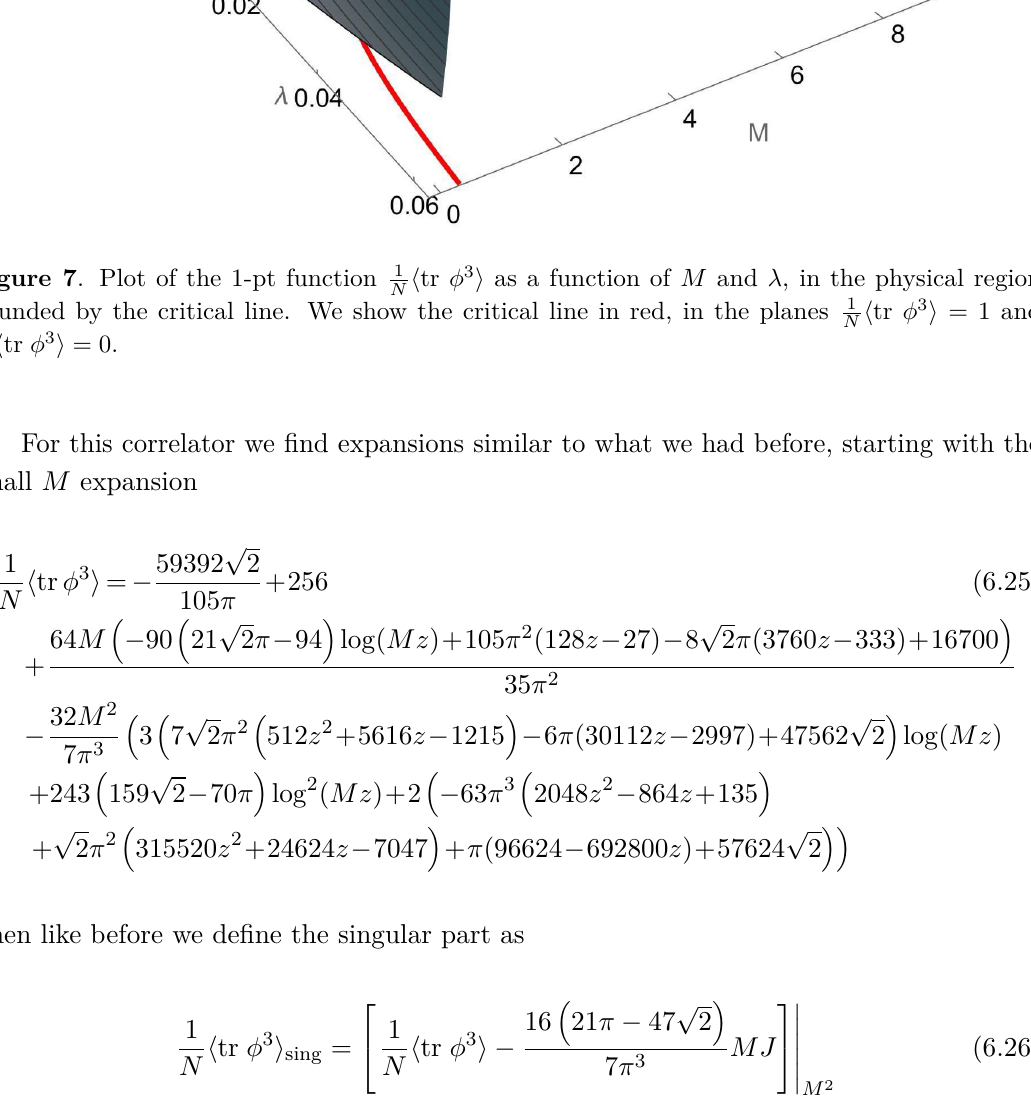
h tr φ 3 i as a function of M and λ , in the physical region N